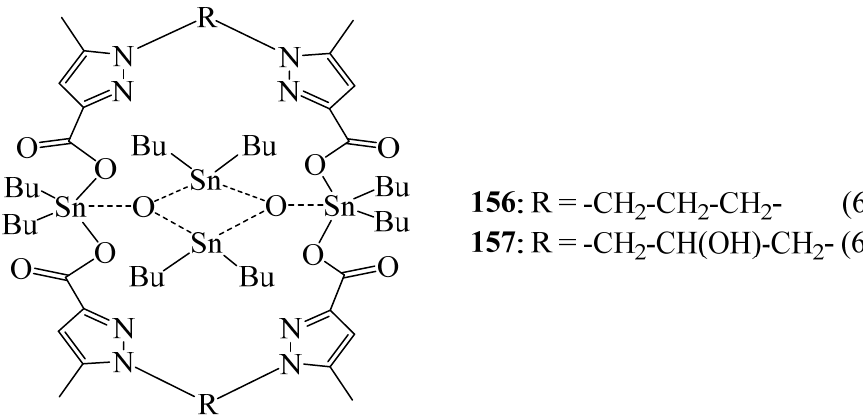
Figure 44. Organotin (IV) bipyrazole-dicarboxylate macrocyclic complexes 156 and 157.